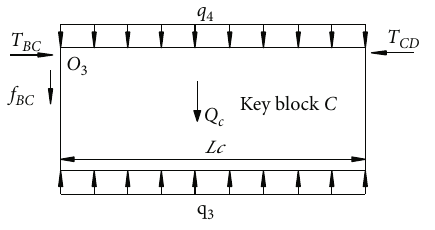
Figure 5: Mechanical analysis of key block C .